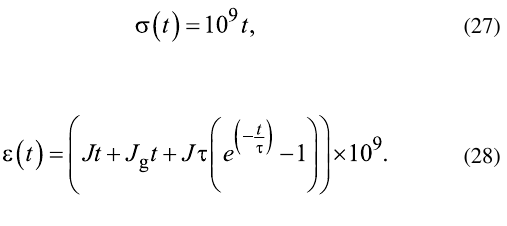
tion 28 below, which gives the theoretical response for the chosen model [13]. The duration of the simulated experiment